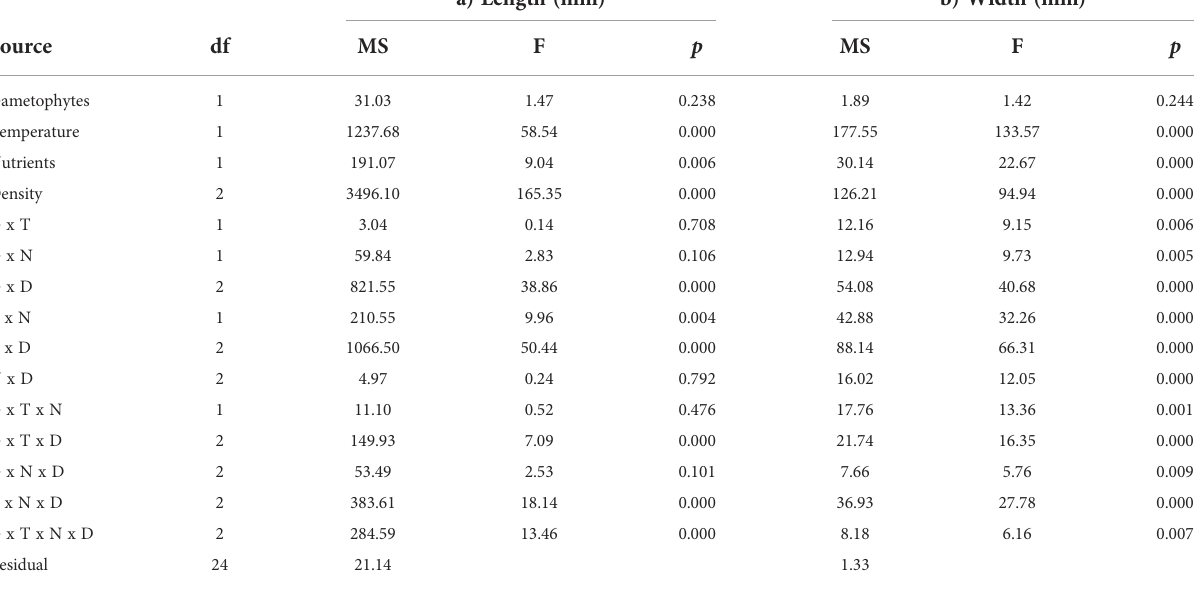
TABLE 1 Analysis of variance of a) length (mm), and b) width (mm) of clonal and recombinant gametophytes (G) exposed to different temperature (T), nutrient concentrations (N) and densities (D) in a 12 week hatchery experiment.